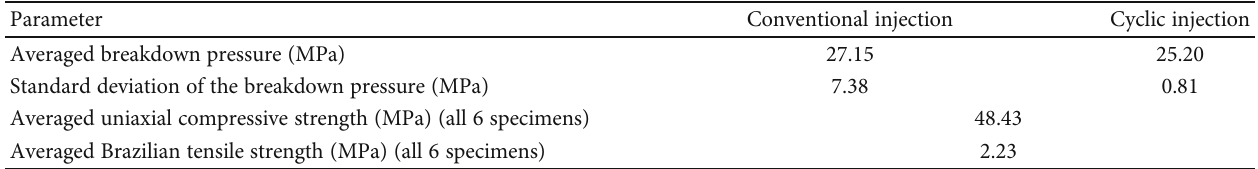
Table 4: Some average results for the second batch of